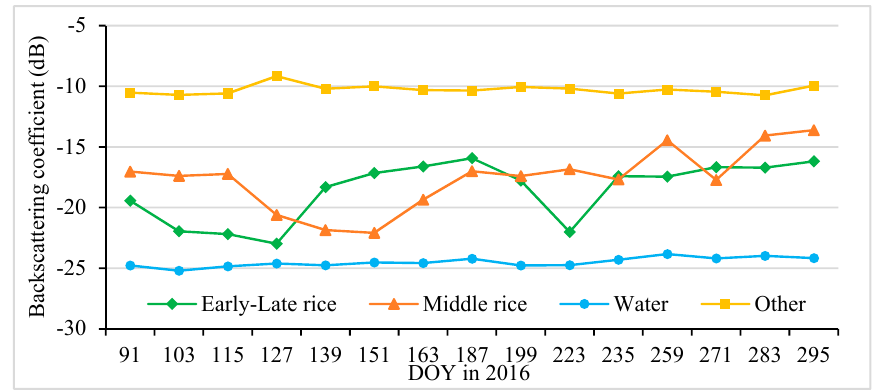
Figure 4. Backscattering coefficients of different remotely-sensed objects. The major objects of interest were early-late rice, middle rice, water and “other” (representing forest and built-up land, which were combined as they had similar coefficients).